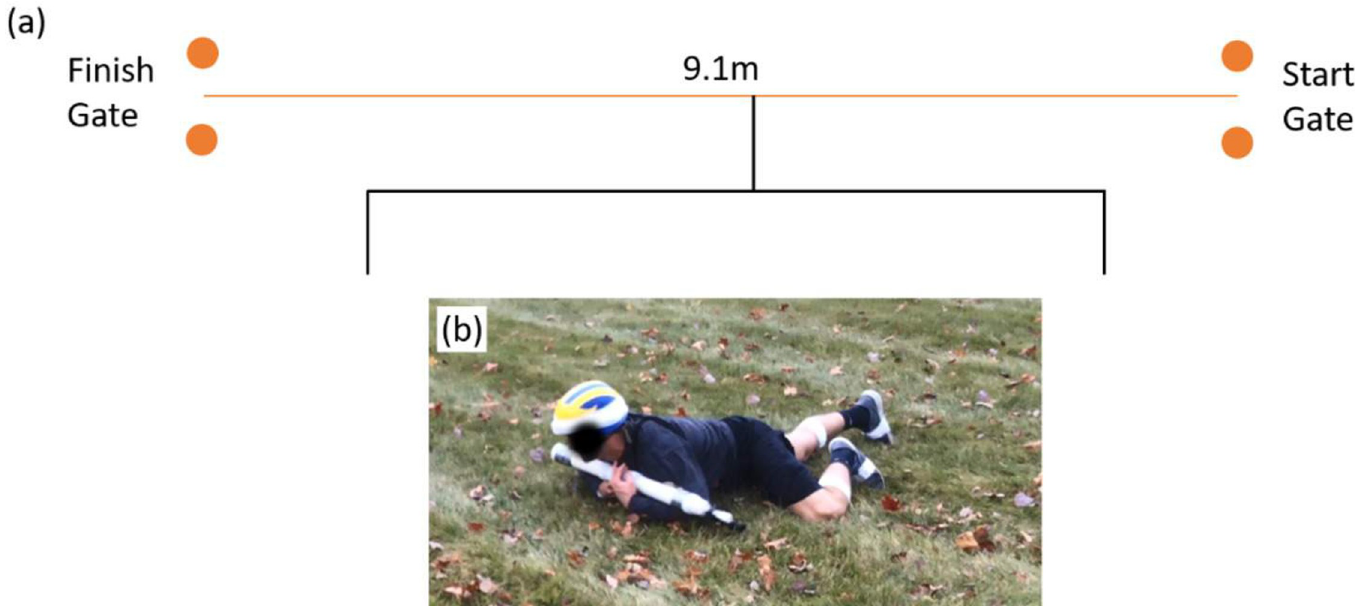
Fig 16. High crawl obstacle. (a) Layout of the high crawl obstacle, and (b) photograph of a participant completing the high crawl.